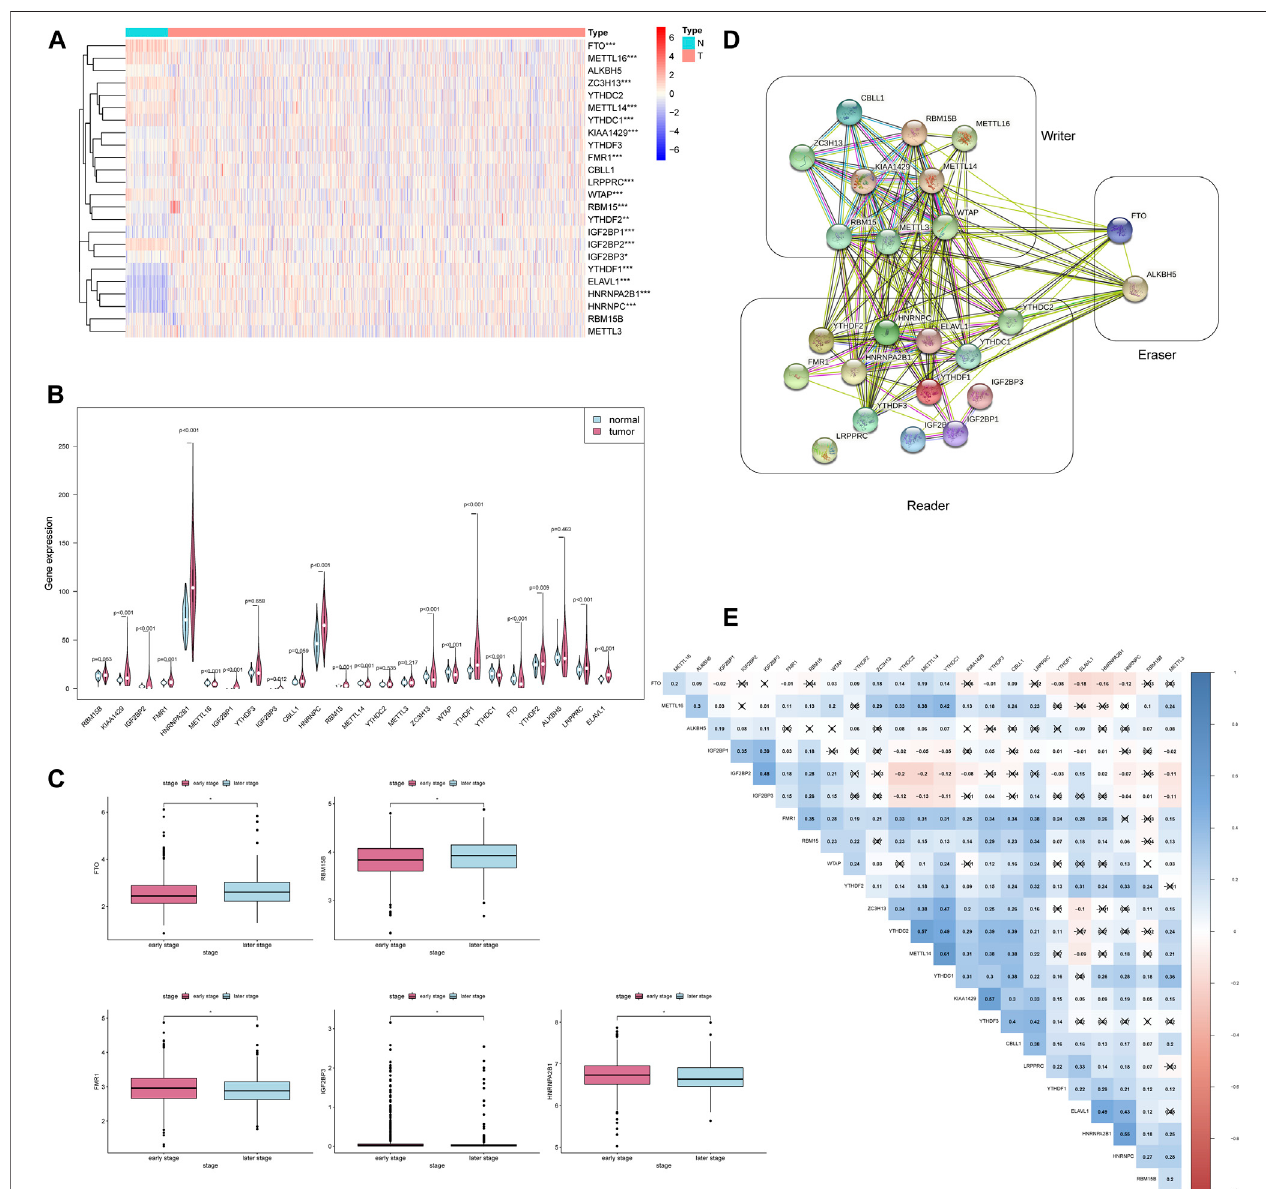
FIGURE2| Theexpression of24m6Aregulators isassociatedwithclinicopathologicalcharacteristics.*** p < 0.001,** p < 0.01,* p < 0.05. (A) Theheatmap of24 m6A regulators in different tumor tissues. (B) The violin plot of 24 m6A regulators in different tumor tissues. (C) The boxplot of 5 m6A regulators in the different pathological stages. (D) The PPI network of the 24 m6A regulators constructed using STRING. (E) Spearman correlation analysis of 24 m6A regulators.